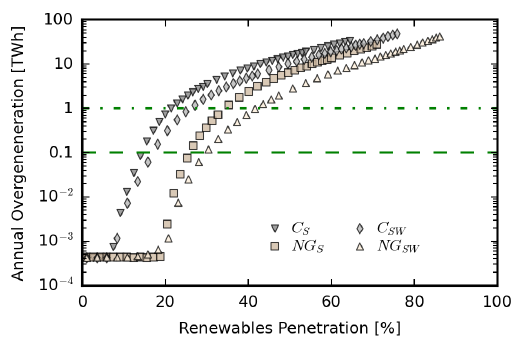
Figure 8. Annual overgeneration for four generation portfolios plotted together with two example imbalance levels at 0.1 and 1 TWh,